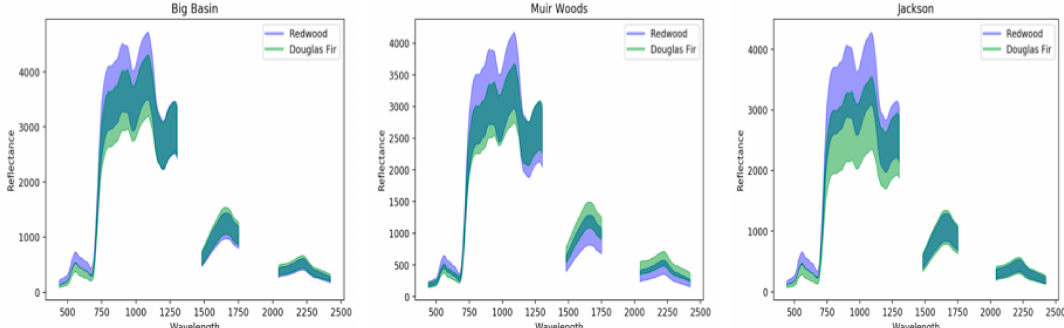
Figure A1. The mean ± one standard deviation of spectral reflectance from redwoods ( Sequoia sempervirens) (transparent blue) and Douglas fir ( Pseudotsuga menziesii) (transparent green). Overlapping regions appear darker blue.